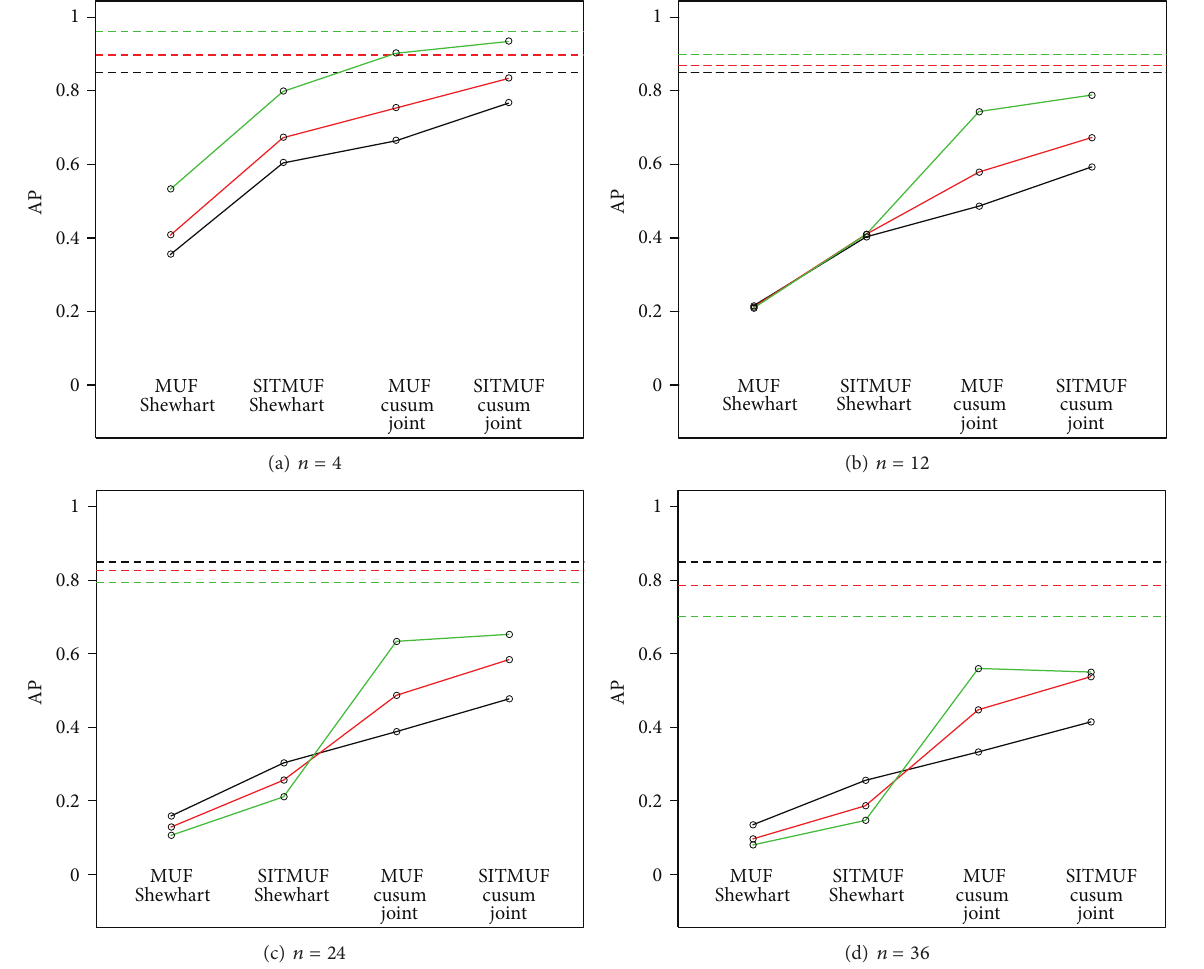
Figure 5: AP for optimal protracted threat for CUMUF, 𝜎 𝑇 = 0.1 , 𝑀 = 4 . (Colors black, red, and green correspond to Σ 1 – Σ 3 . Dashed lines are for